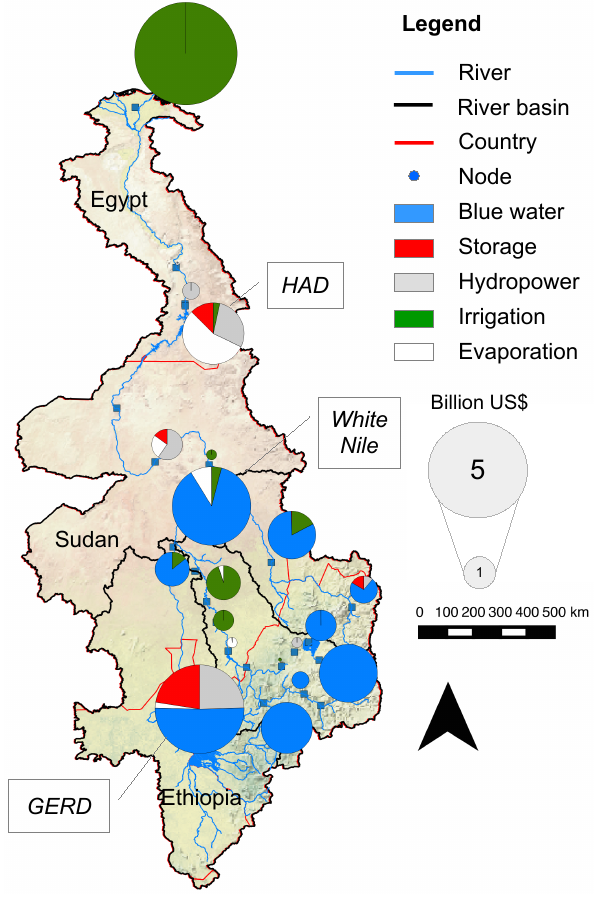
Figure 5. Average annual water accounts – Eastern Nile River